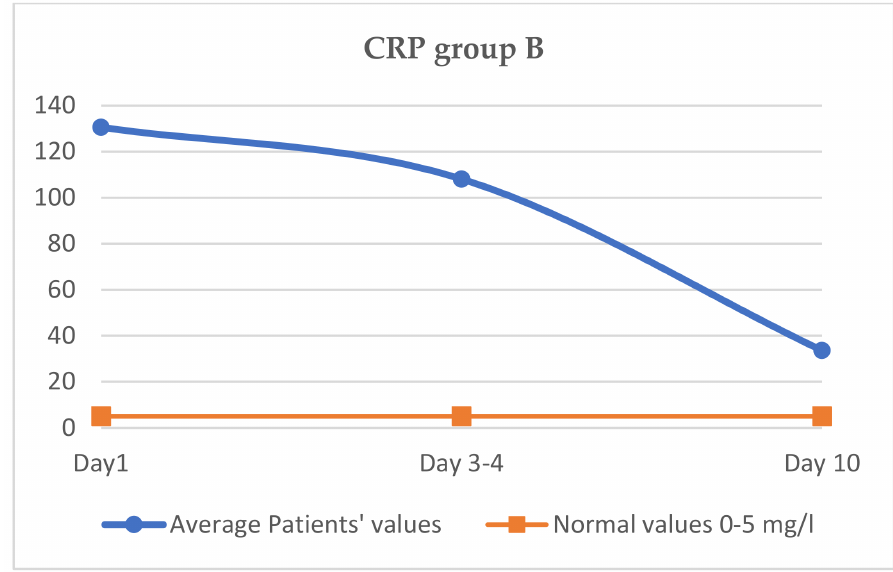
Figure 4. Variation CRP group B. 3.7. The Evaluation of Lacticodehydrogenase (Normal Values 0–247 u/L, in Cytokine Storm, Increasesto over 300 u/L